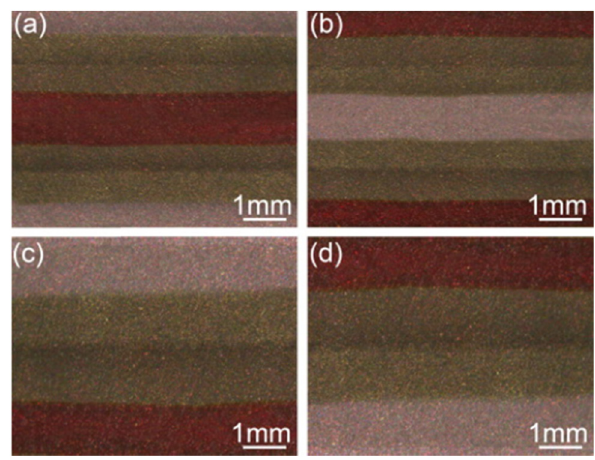
Figure 3: Optical images of the polished cross section: ( a ) FGN - 1, ( b )